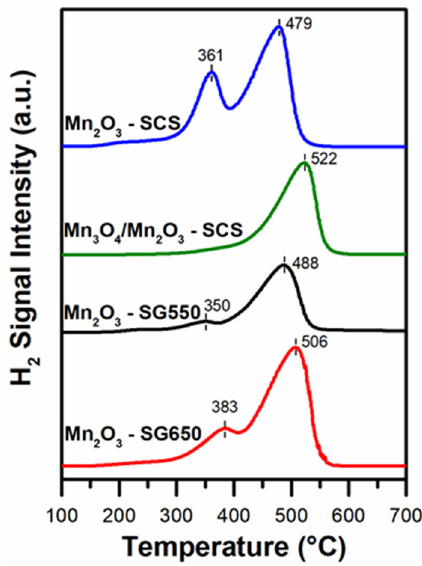
Figure 3. H 2 -TPR of the synthesized catalysts.